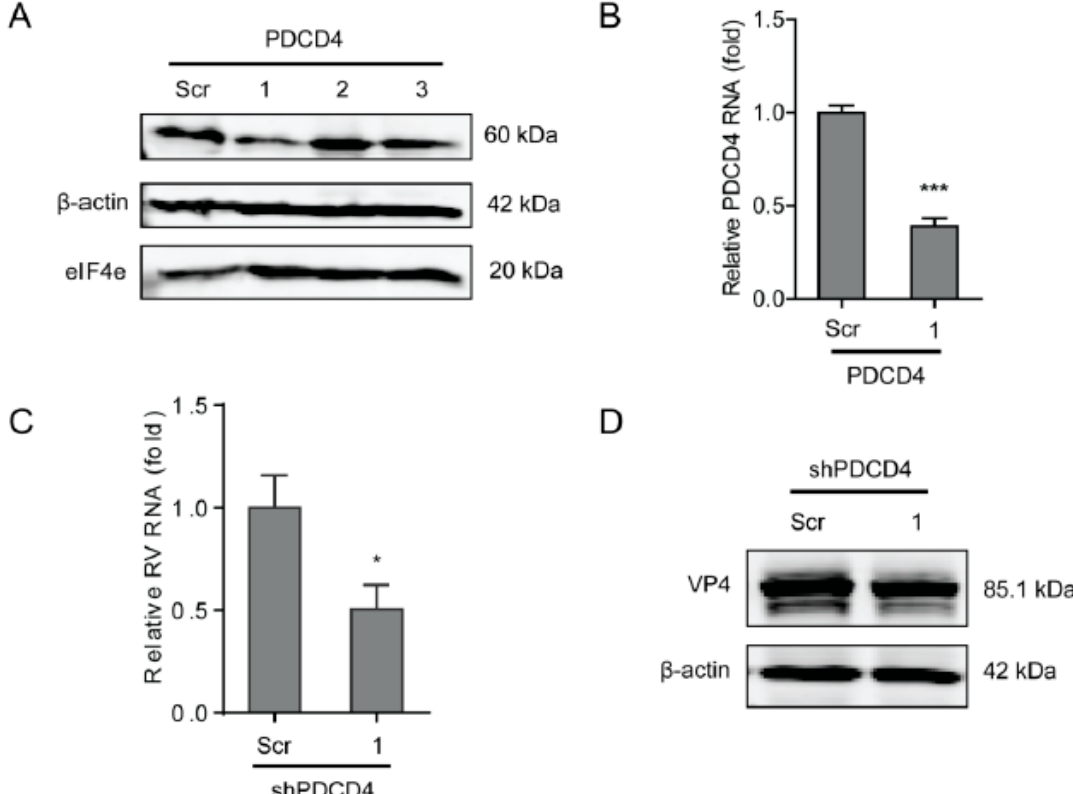
Figure 5. Programmed cell death protein 4 (PDCD4) sustains rotavirus infection. ( A ) Western